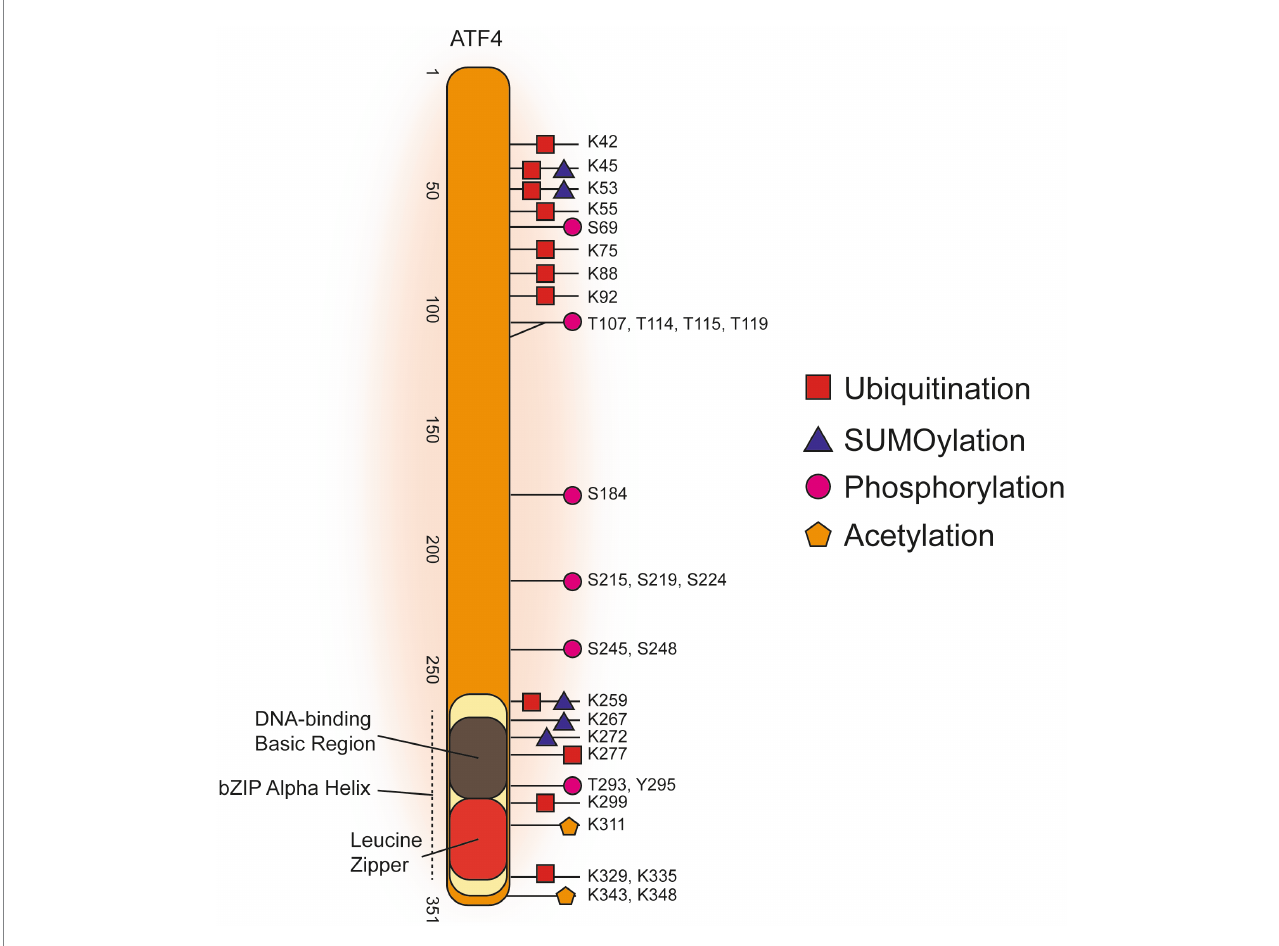
FIGURE 3 Post-translational Modifications of Human